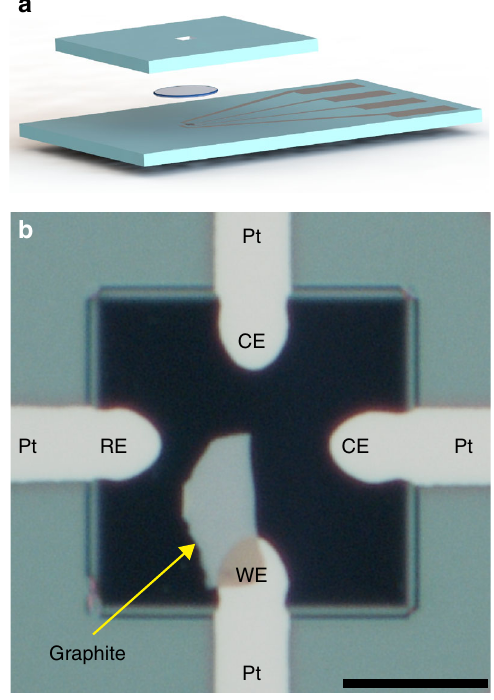
Fig. 1 Fluid cell construction. a Exploded schematic of the electrochemical fl uid cell. A drop of H 2 SO 4 (disk) is sandwiched between two electron- transparent Si 3 N 4 windows framed by silicon chips. b Optical micrograph showing a graphite single crystal on a bottom-chip window, before the H 2 SO 4 and the top chip are added. Four platinum contacts converge over the window; the working (WE), pseudo-reference (RE), and counter (CE) electrodes are labeled. The scale bar is 10 μ